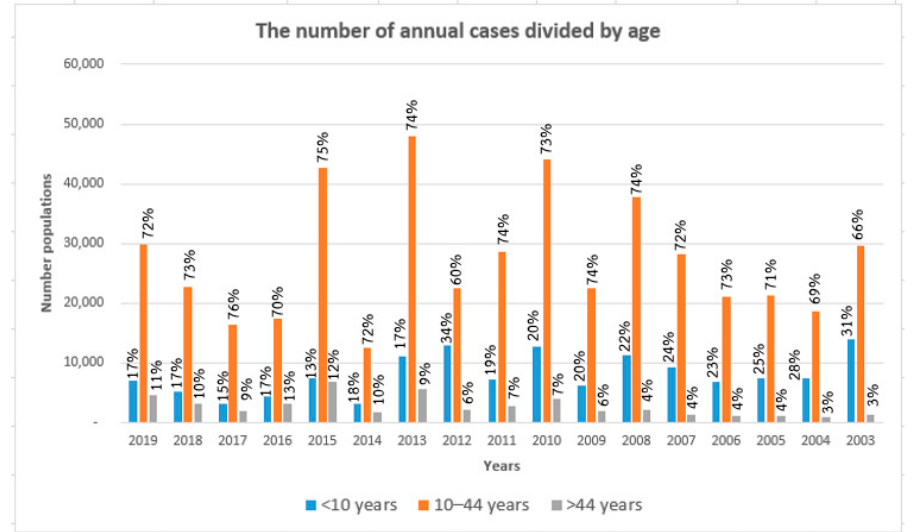
Figure 2. The number of infected cases each year from 2003–2019 for each of the three age groups [14].